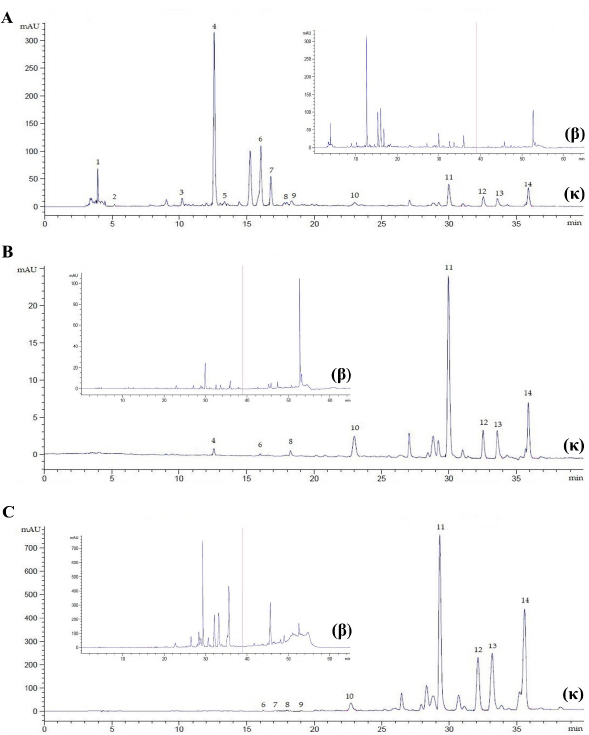
Figure 3. Chromatogram of P. sarmentosum leaves at λ = 272 nm, flow rate 0.9 mL/min, for 40 min ( κ ) and 65 min ( β ). ( A ), methanolic extract (20× dilution); ( B ), chloroformic extract (20× dilution); ( C ), hexanoic extract (5× dilution). Peak 1, ascorbic acid; 2, gallic acid; 3, catechin; 4, caffeic acid; 5, syringic acid; 6, rutin; 7, p -coumaric acid; 8, sinapic acid; 9, ferulic acid; 10, myricetin; 11,